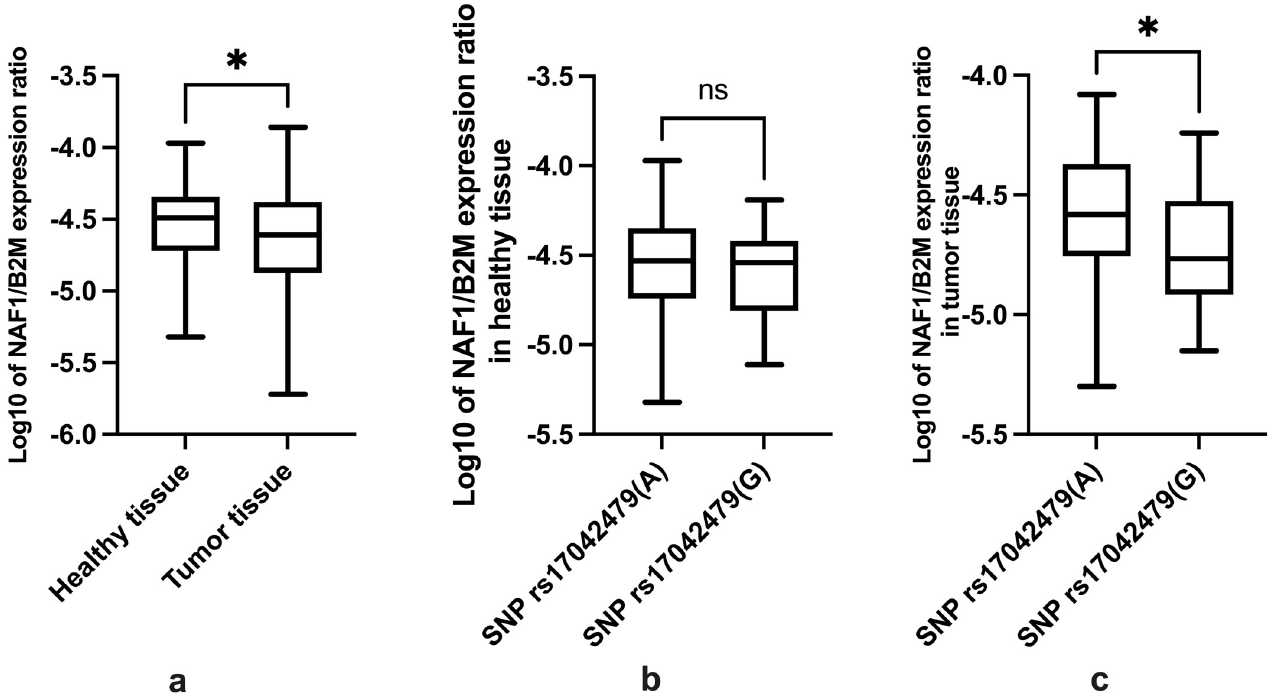
Fig 3. (a) Boxplot of NAF1 expression in respectively healthy and tumor tissue. The patients with tumor content under 50% are not included in the analysis. n = 121. The log transformed data was examined by paired t-test; p-value = 0.012. (b) Boxplot of the NAF1 expression in healthy tissue and the presence of SNP rs17042479(G). n = 43 for patients with the risk allele and n = 155 for patients with the reference allele. The analysis was examined by unpaired t-test; p- value = 0.28. (c) Boxplot of the NAF1 expression in tumor tissue and the presence of SNP rs17042479. The patients with tumor content under 50% are not included in the analysis. n = 22 for patients with the alternative allele, and n = 99 for patients with the reference allele. The analysis was examined by unpaired t- test; p-value = 0.05.